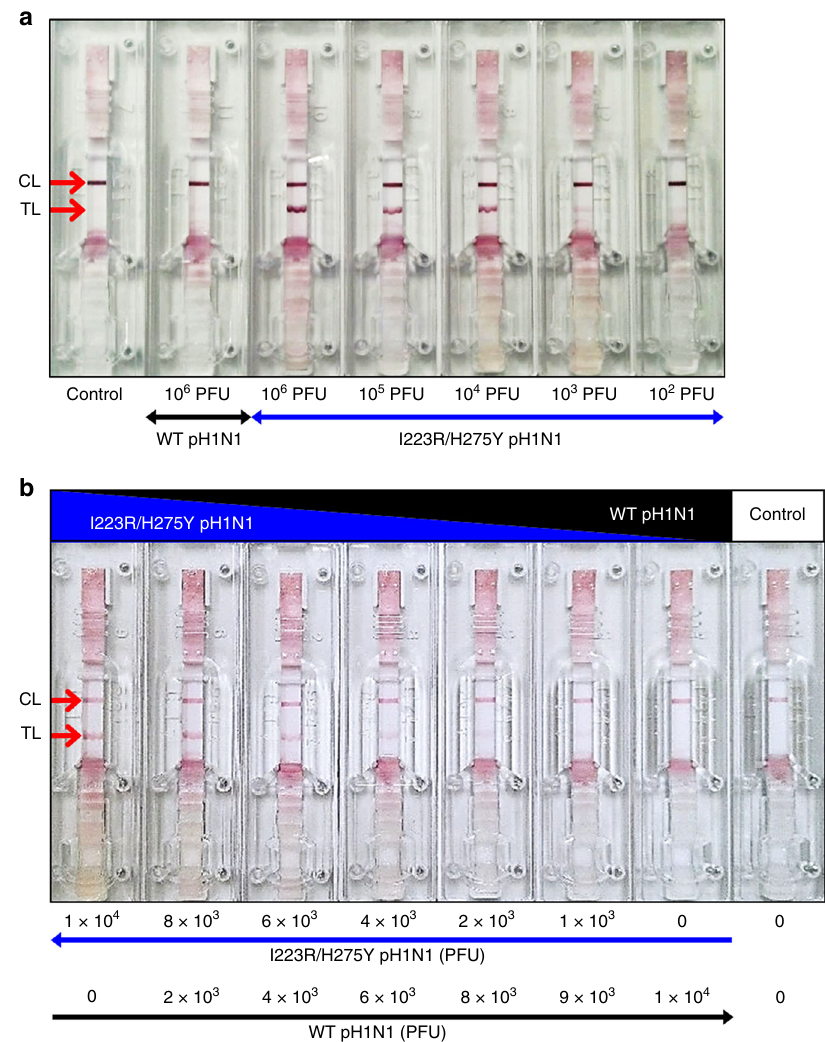
Fig. 7 LFA of I223R/H275Y pH1N1 using A4. a Optical images of A4-based lateral fl ow systems after detection of I223R/H275Y pH1N1, wt pH1N1, and control sample. b Optical images of A4-based lateral fl ow systems after detection of I223R/H275Y and wt pH1N1 mixture in nasal fl uid and control